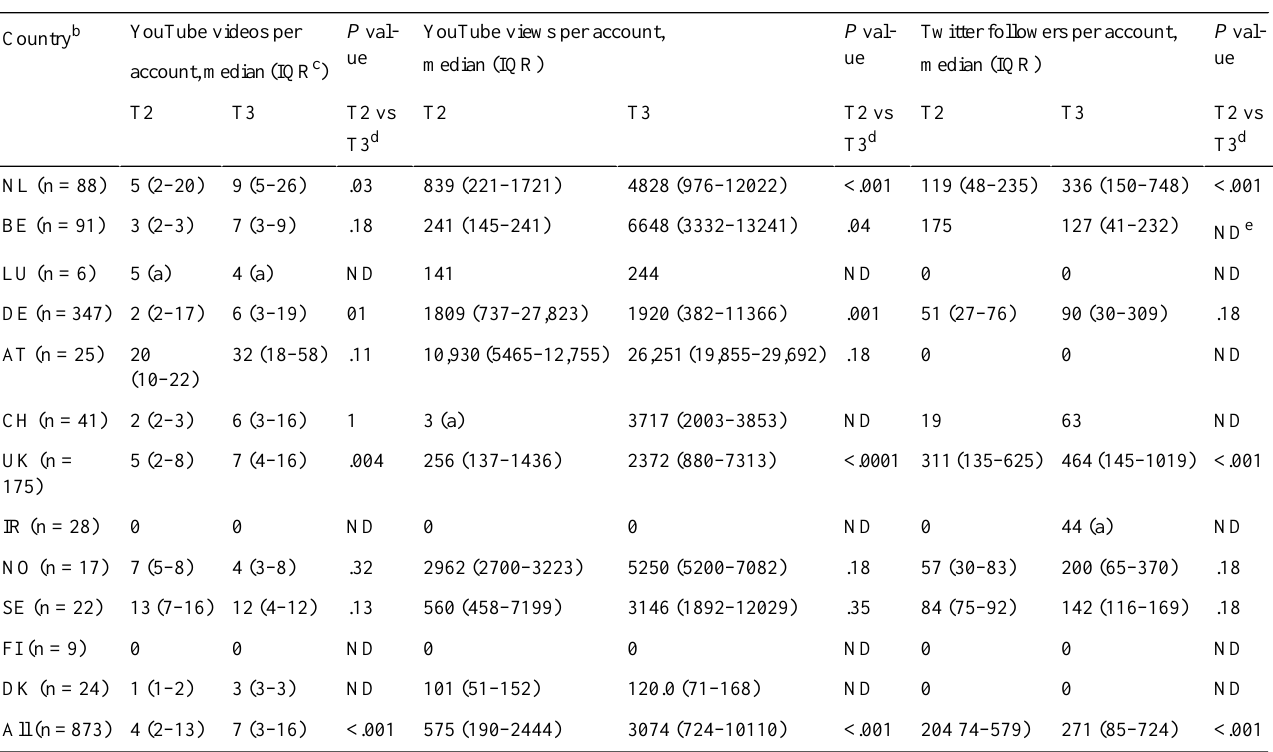
Table 5. YouTube videos, views, and Twitter followers at T2 and T3 a .